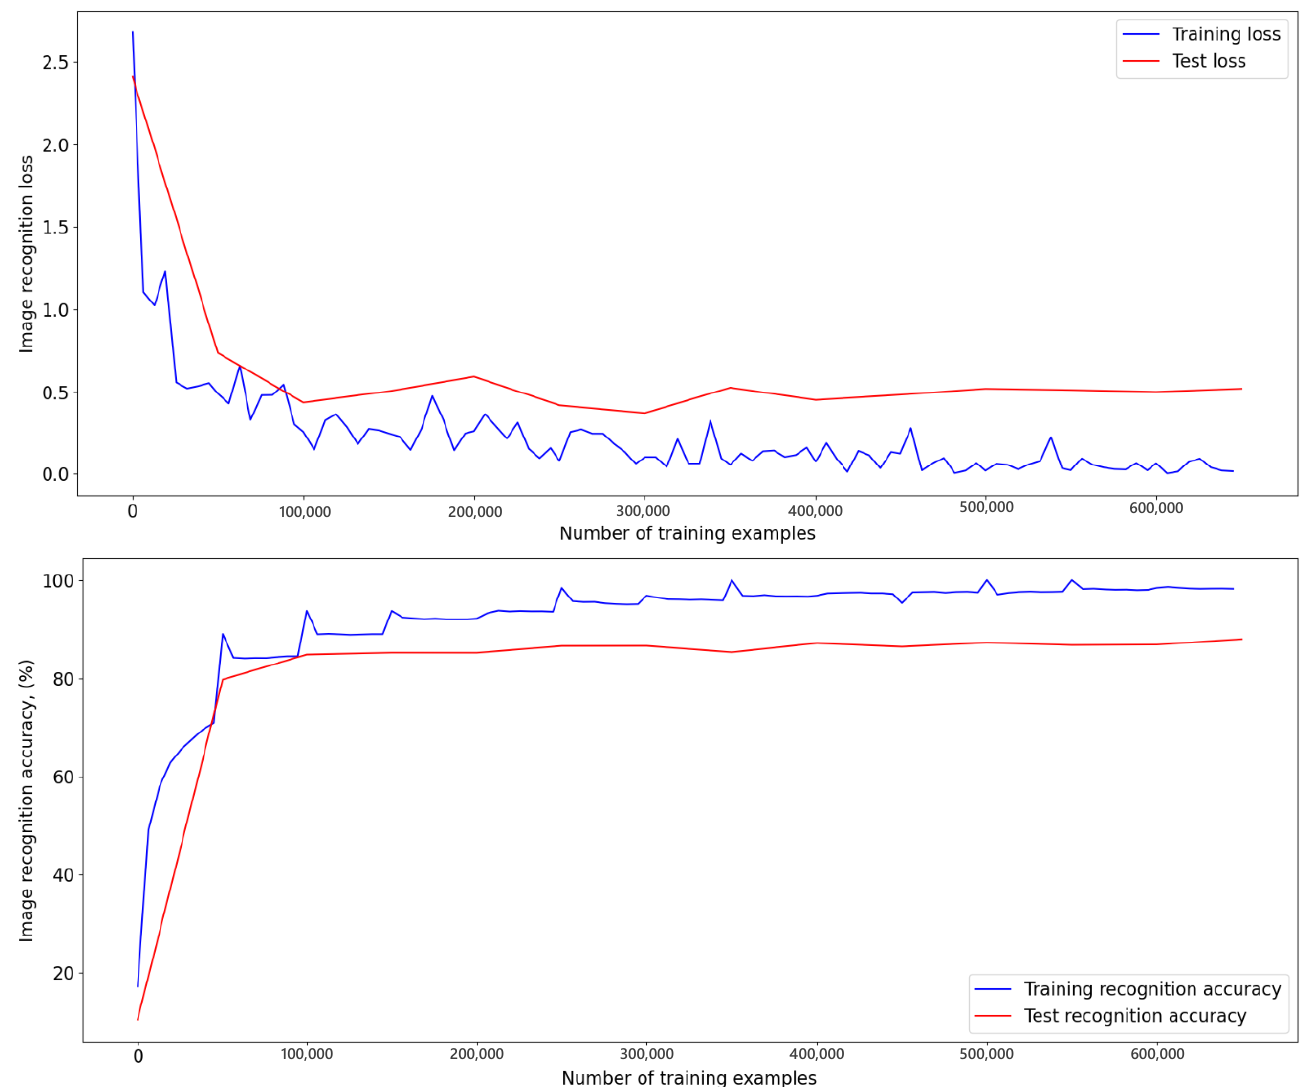
Figure 3. Training plots and losses plots for the VGG16 network over 13 epochs, the maximum ac- curacy reached is 87.99%. accuracy reached is